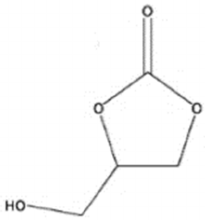
Figure 4. The glycerol carbonate molecular structure. Table 2. The comparison of properties between glycerol carbonate and pure glycerol.